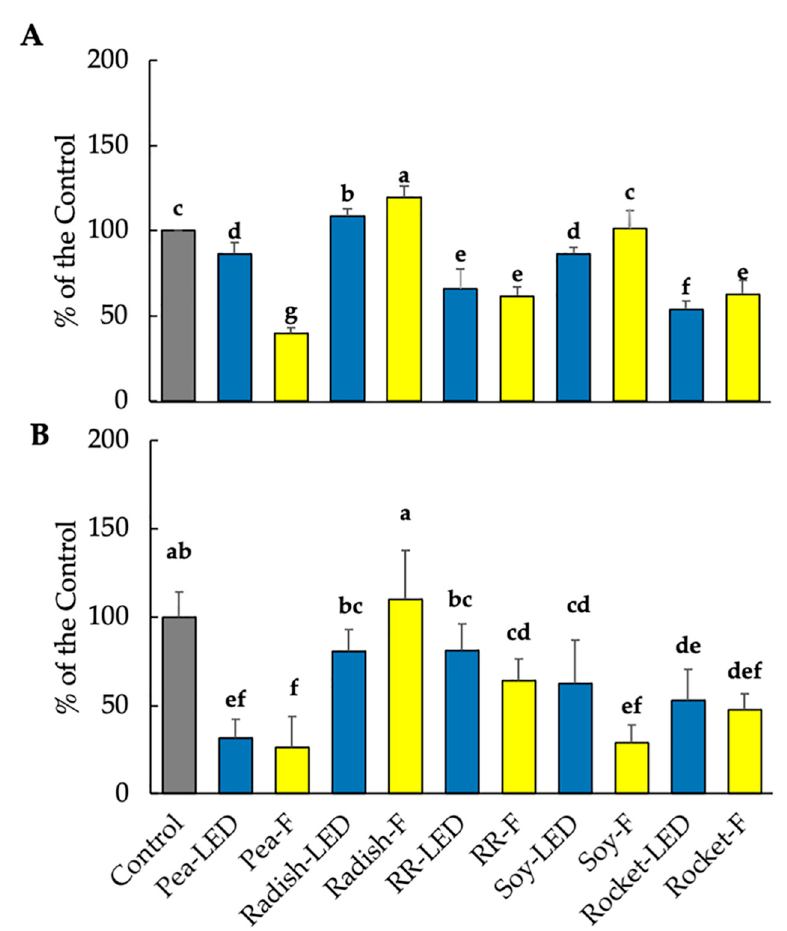
Figure 6. Cell vitality (MTT assay) on healthy L929 fibroblasts ( A ), and 3D RD-ES ( B) exposed for 24 h to 40 µ L green pea, radish, Red Rambo (RR), soybean (soy), and rocket microgreen extracts, cultivated under LED and fluorescent (F) lighting. Values are the mean ± SD of six replicates ( n = 6). The different lowercase letters (a–f) represent significant differences in the microgreen species under different lighting for each treatment ( p < 0.05), as determined from a one-way ANOVA. After exposure for 120 h to 40 μ L green pea extract, there was a significant increase